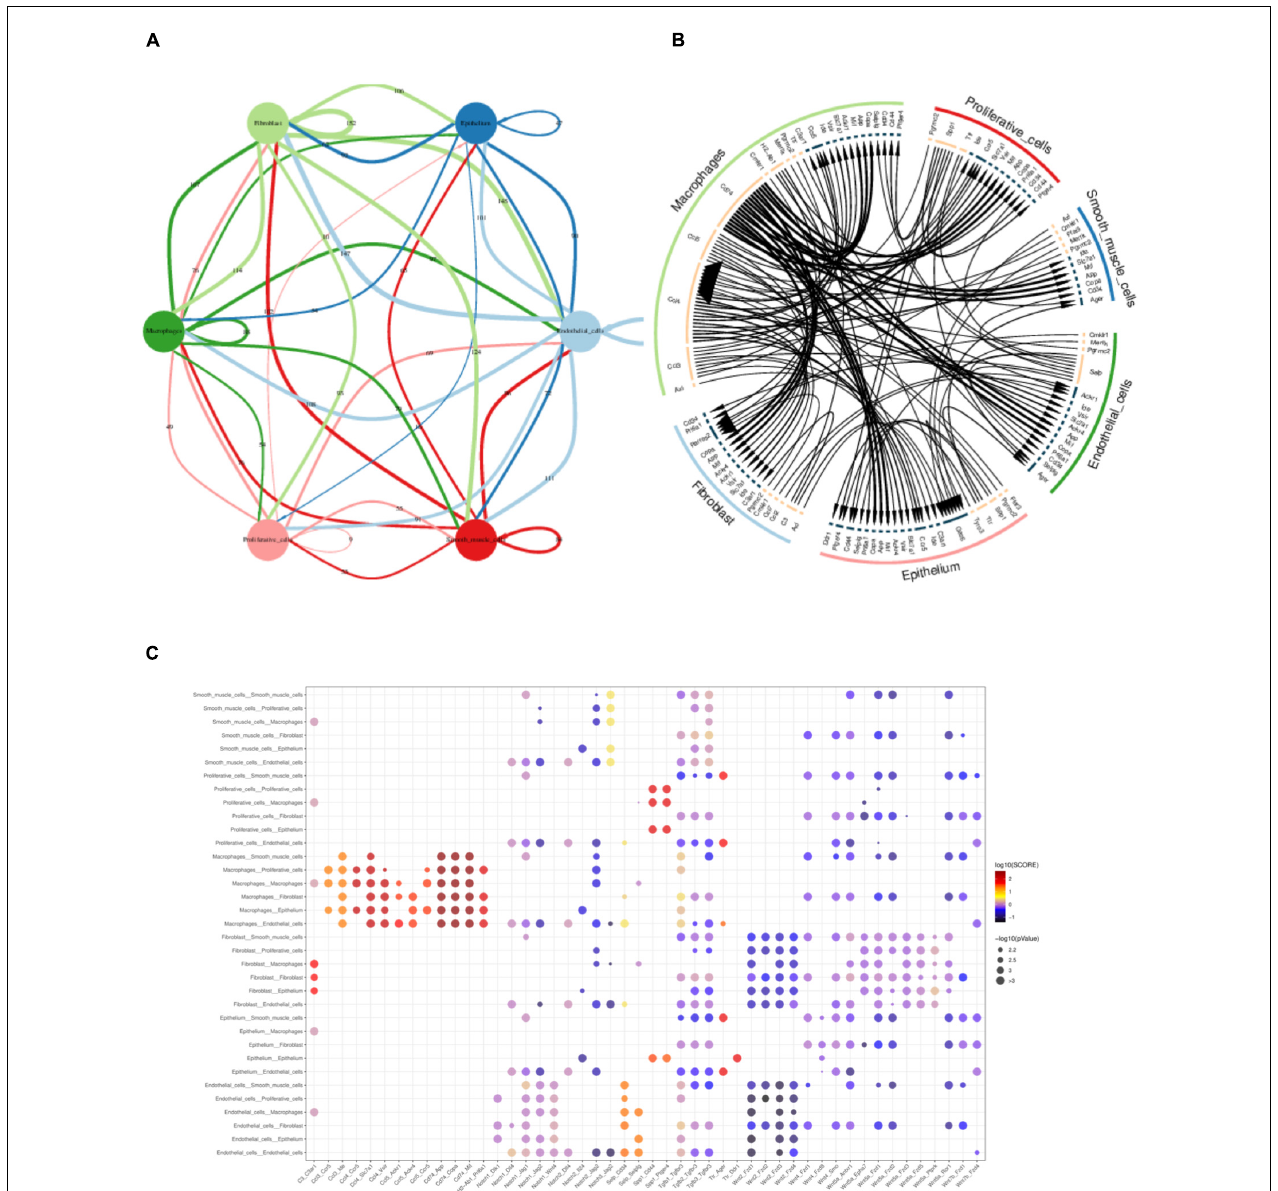
FIGURE 8 | Multi-interactions across and within cell types assessed by CellPhone analysis. (A) Summary network showing the level of signaling across and within cell types. Edges were scaled and numbered with the number of ligand-receptor pairs between cell types. (B) Chord diagram showing the preferential interactions of ligand-receptors across and within cell types. Edges of lines were scaled according to the interaction scores of ligand-receptor pairs. (C) Heatmap showing the interaction scores of ligand-receptor pairs between cell